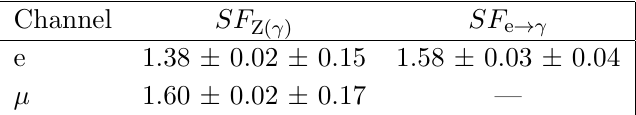
increase the purity of the misidenti(cid:12)ed e (cid:13) mass template. To increase the statistics